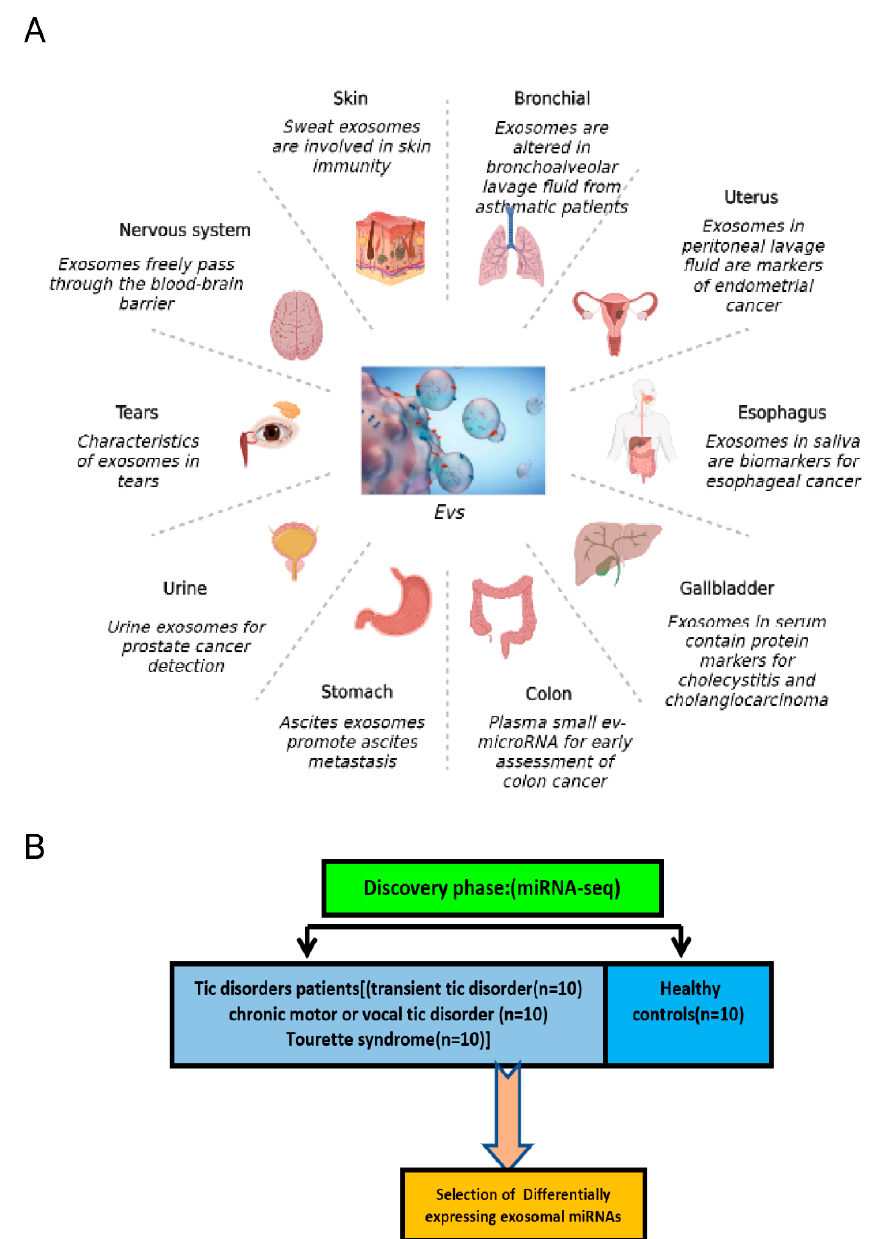
Figure 1. Schematic overview of study design. ( A ) Exosomes play an ir-replaceable role in various diseases in different systems. ( B ) A total of 10 children with transient tic disorders, 10 children with chronic motor or vocal tic disorder, 10 children with Tourette syndrome, and 10 children who were neurological typical were included in the current research. RNA-seq was operated to identify small extracellular vesicle-derived miRNAs with differential expression levels and followed by bioinfor- matics analysis and functional prediction. Table 1. Clinical features of all participants.